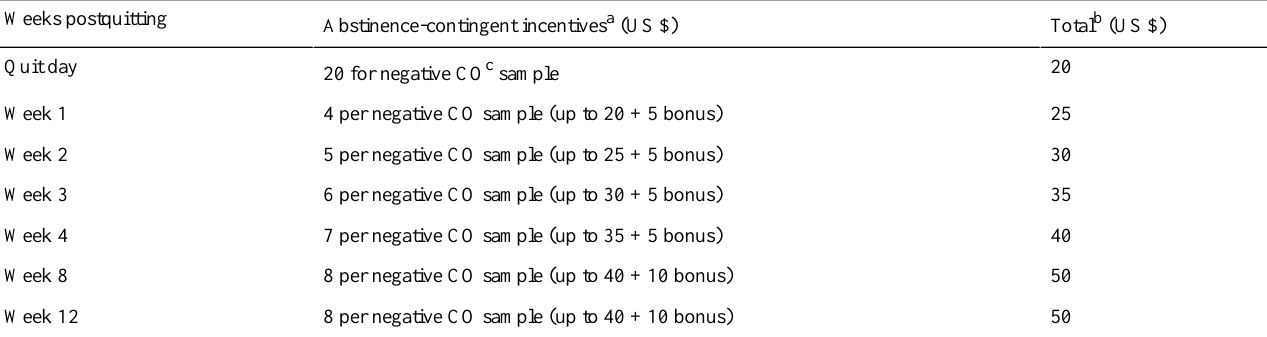
Table 1. Incentive